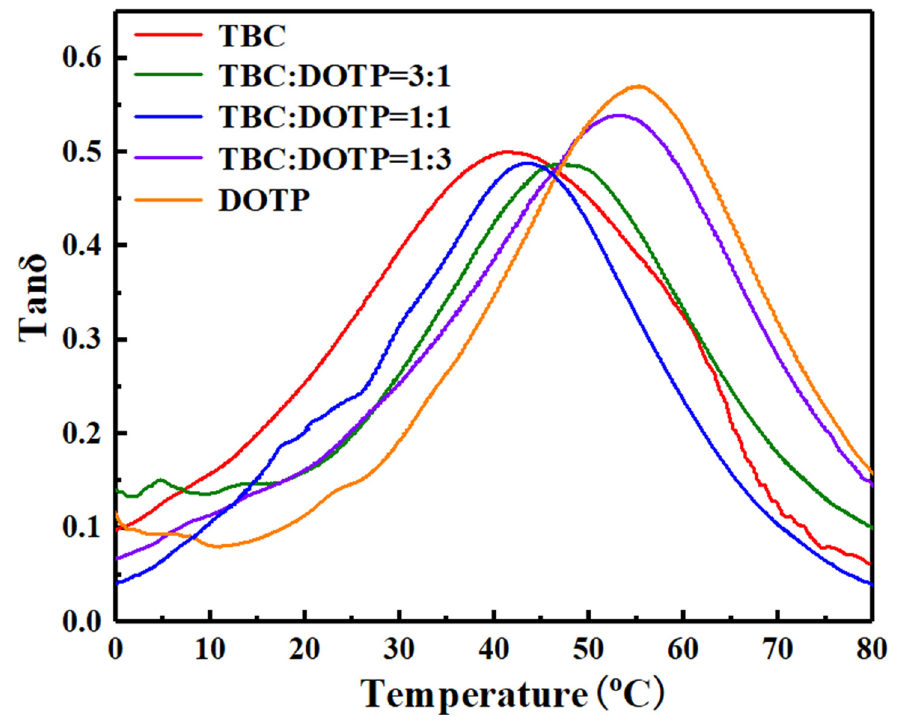
Figure 13. The tan δ of PVC with Zn(Arg) 2 plasticized by TBC and DOTP in different proportions.